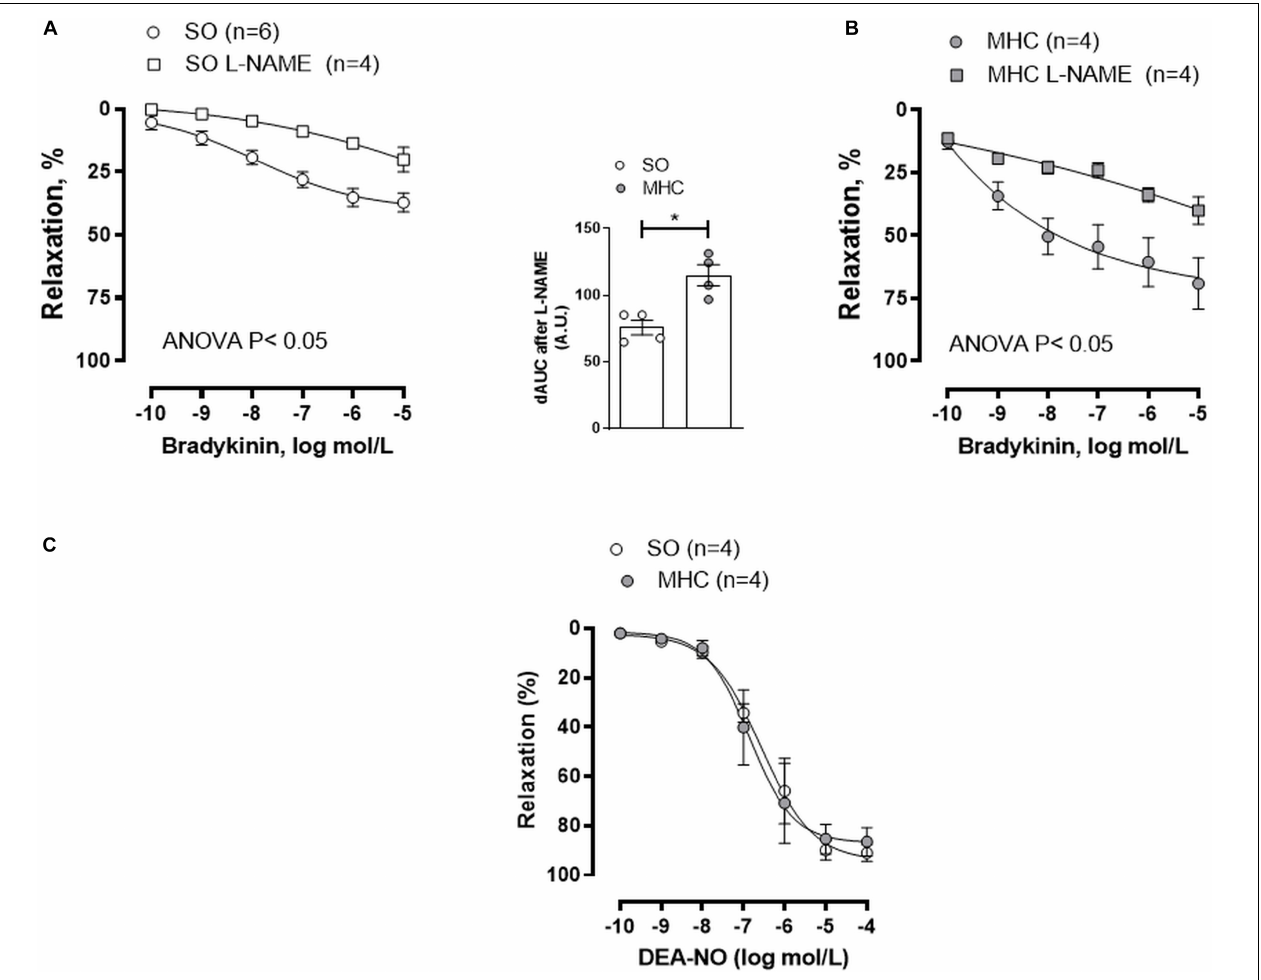
FIGURE 3 | Effect of preincubation with NOS inhibitor L -NAME on the concentration-dependent relaxation to bradykinin in rat middle cerebral arteries from Sham-Operated (SO), (A) ; ( n = 4–6 segments from different animals) and microsurgical liver cholestasic (MHC), (B) ; ( n = 4 segments from different animals) rats. Results (mean ± SEM) were expressed as a percentage of the initial contraction elicited by 5HT. The attached graph shows the differences of area under the curve (dAUC) to bradykinin for segments in the absence or presence of 0.1 mmol/L L -NAME. dAUC values are expressed as a percentage of the difference of the corresponding AUC for the segments in the absence of L -NAME. (C) Vasodilator response to NO donor DEA-NO in arteries from SO and MHC rats ( n = 4 segments from different animals in each group). Results (mean ± SEM) were expressed as a percentage of the initial contraction elicited by